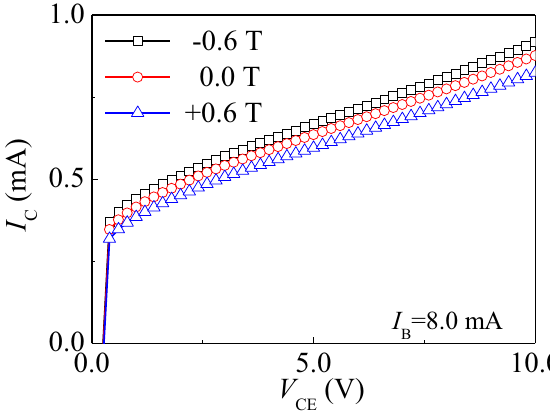
Figure 10. I C – V CE characteristics of the HSMST under different B .